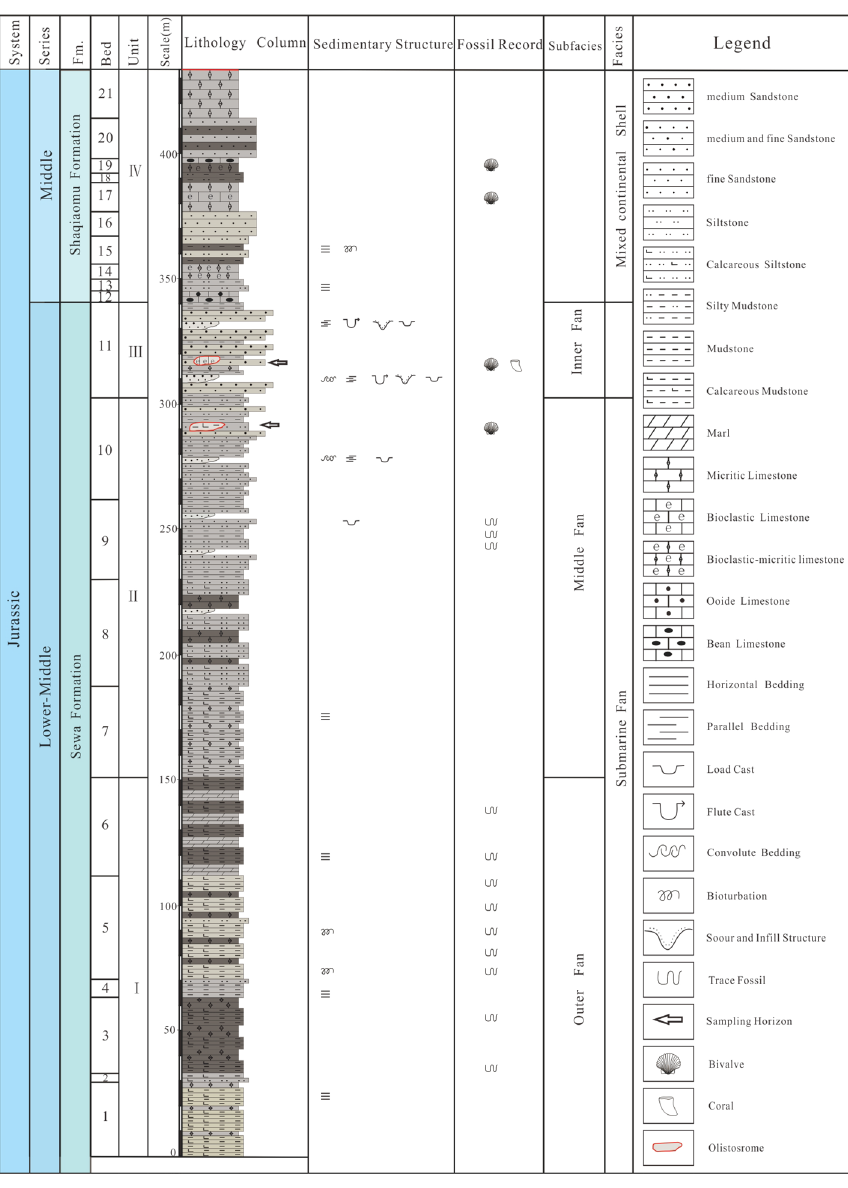
Figure 2. The stratigraphic log of the Rigenco section in the northeastern Riganpeicuo area in the South Qiangtang Basin, Tibet. Fm. =